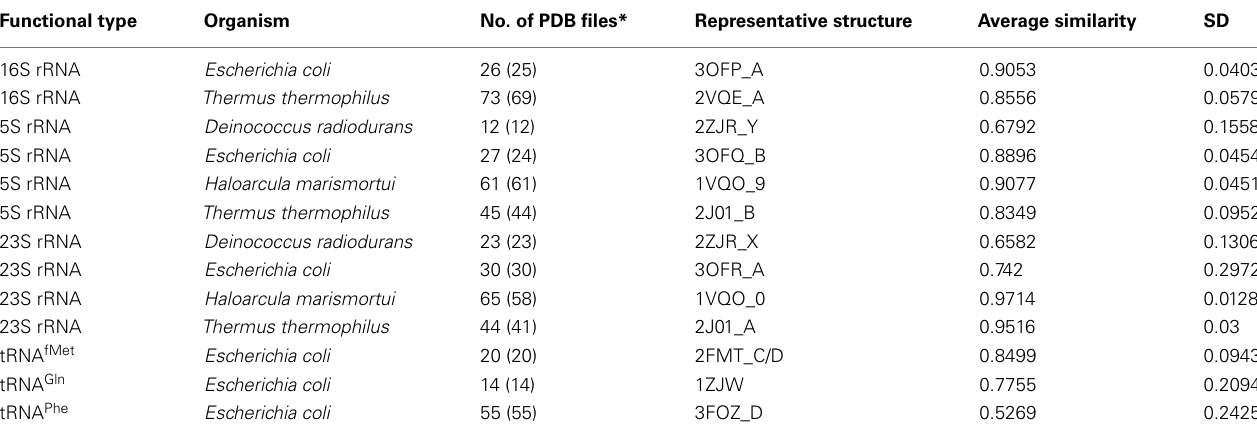
Table 3 | Subclasses where the number of PDB files are 10 or greater and their structural variation.